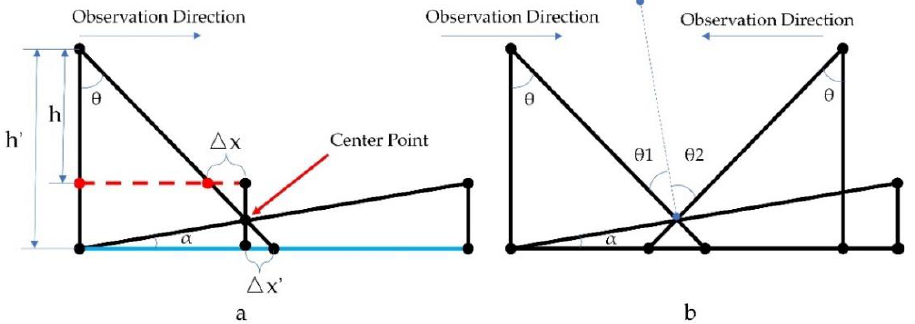
Figure 8. Schematic diagram of influence of slope on ( a ) projection point location and ( b ) incident angle.